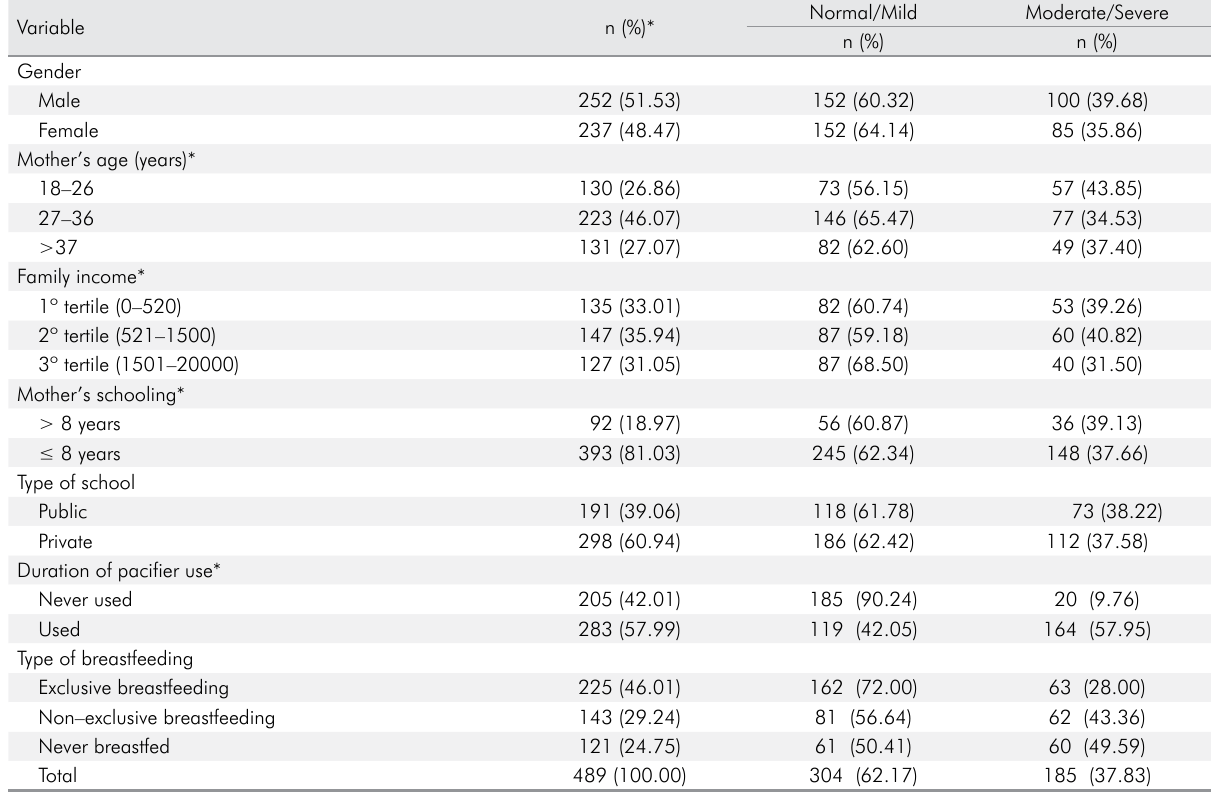
Table 1. Characteristics of the sample and occlusal status in preschool children in Pelotas, RS-Brazil (n = 489). Variable